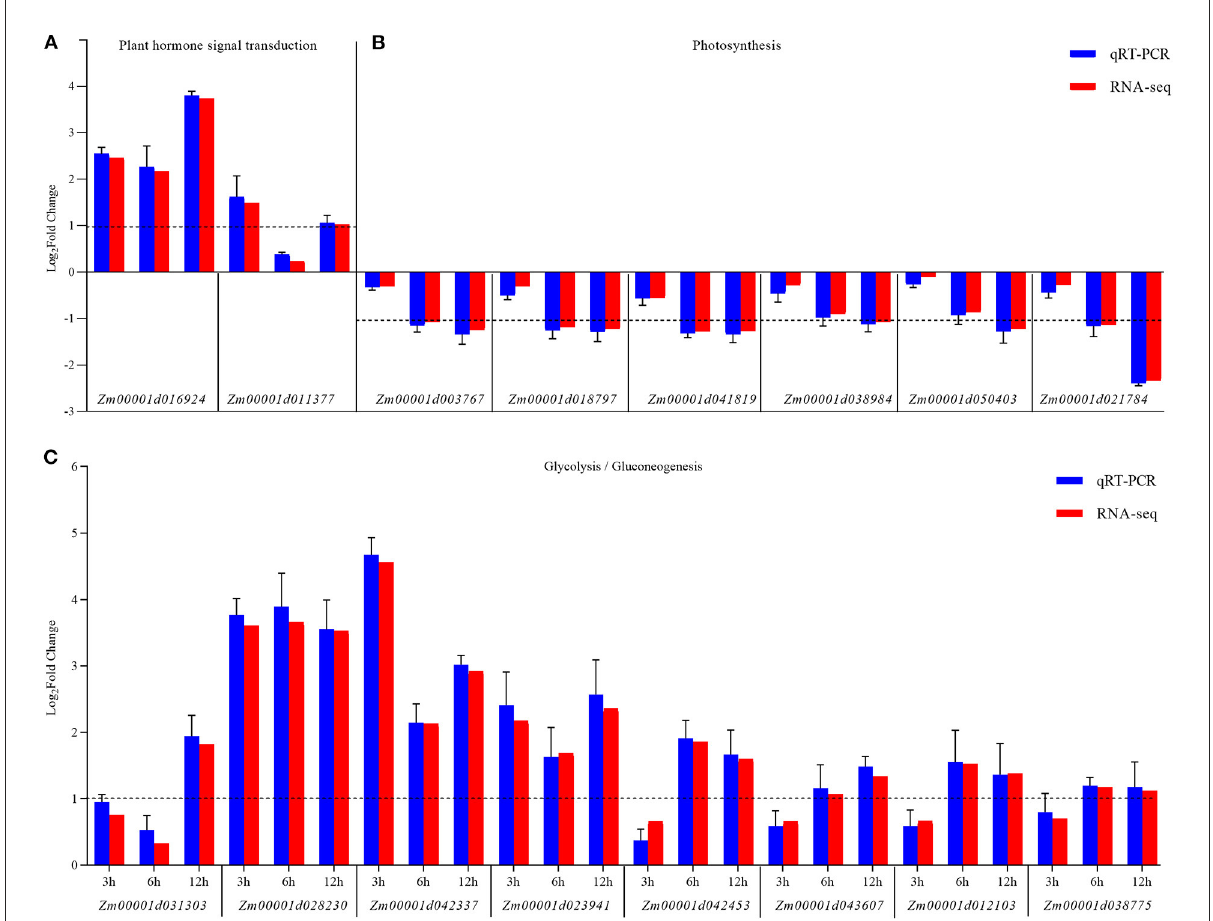
FIGURE6 qRT-PCR validation of the expression of KEGG pathway-related genes differentially expressed between the control (CK) and Ustilago maydis- infected samples (Inf) at 3, 6, and 12 hpi, respectively. (A) Plant hormone signal transduction pathway-related genes. (B) Photosynthesis-related genes. (C) Glycolysis/gluconeogenesis-related genes. The blue bars represent the Log 2 -fold change in expression levels based on qRT-PCR, and the red bars represent the Log 2 -fold change in expression levels based on RNA-seq. Error bars indicate the standard deviation of three biological replicates. The dotted line is shown at a Log 2 -fold change of 1; genes with a fold change ≥ 2 were identified as differentially